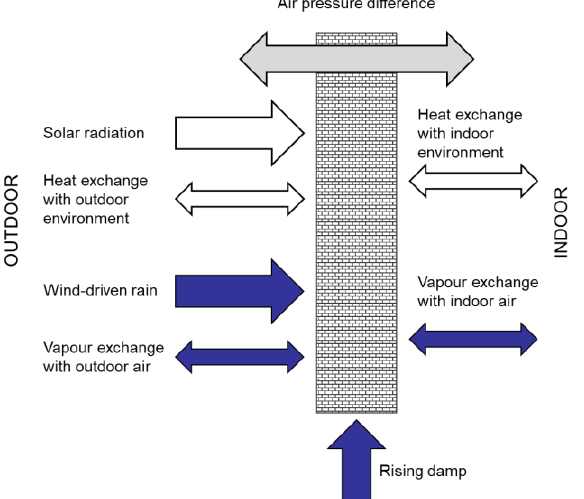
Figure 2. Hygrothermal loads and interchanging periodical directions on building envelope.